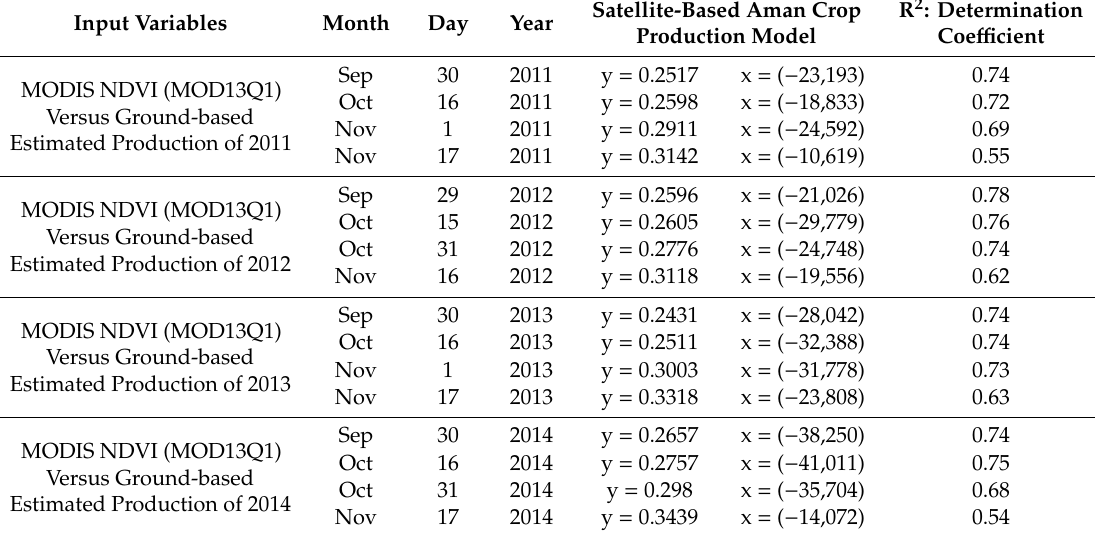
Table A1. Satellite remote sensing based monthly scale regression models for Aman crop production